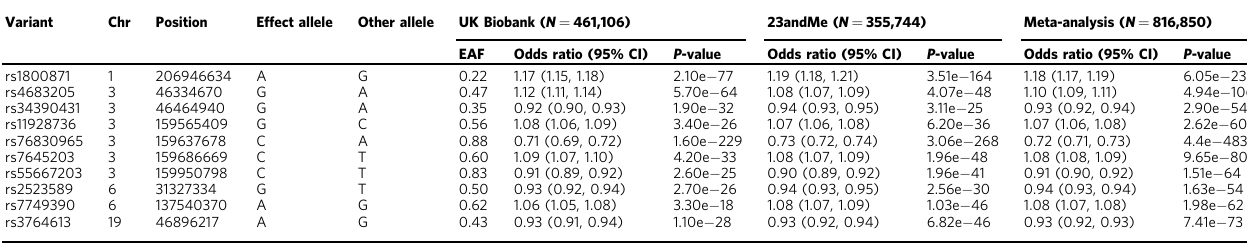
Table 2 Ten lead single variant results from GWAS in UK Biobank, replication in 23andMe and after Meta-analysis